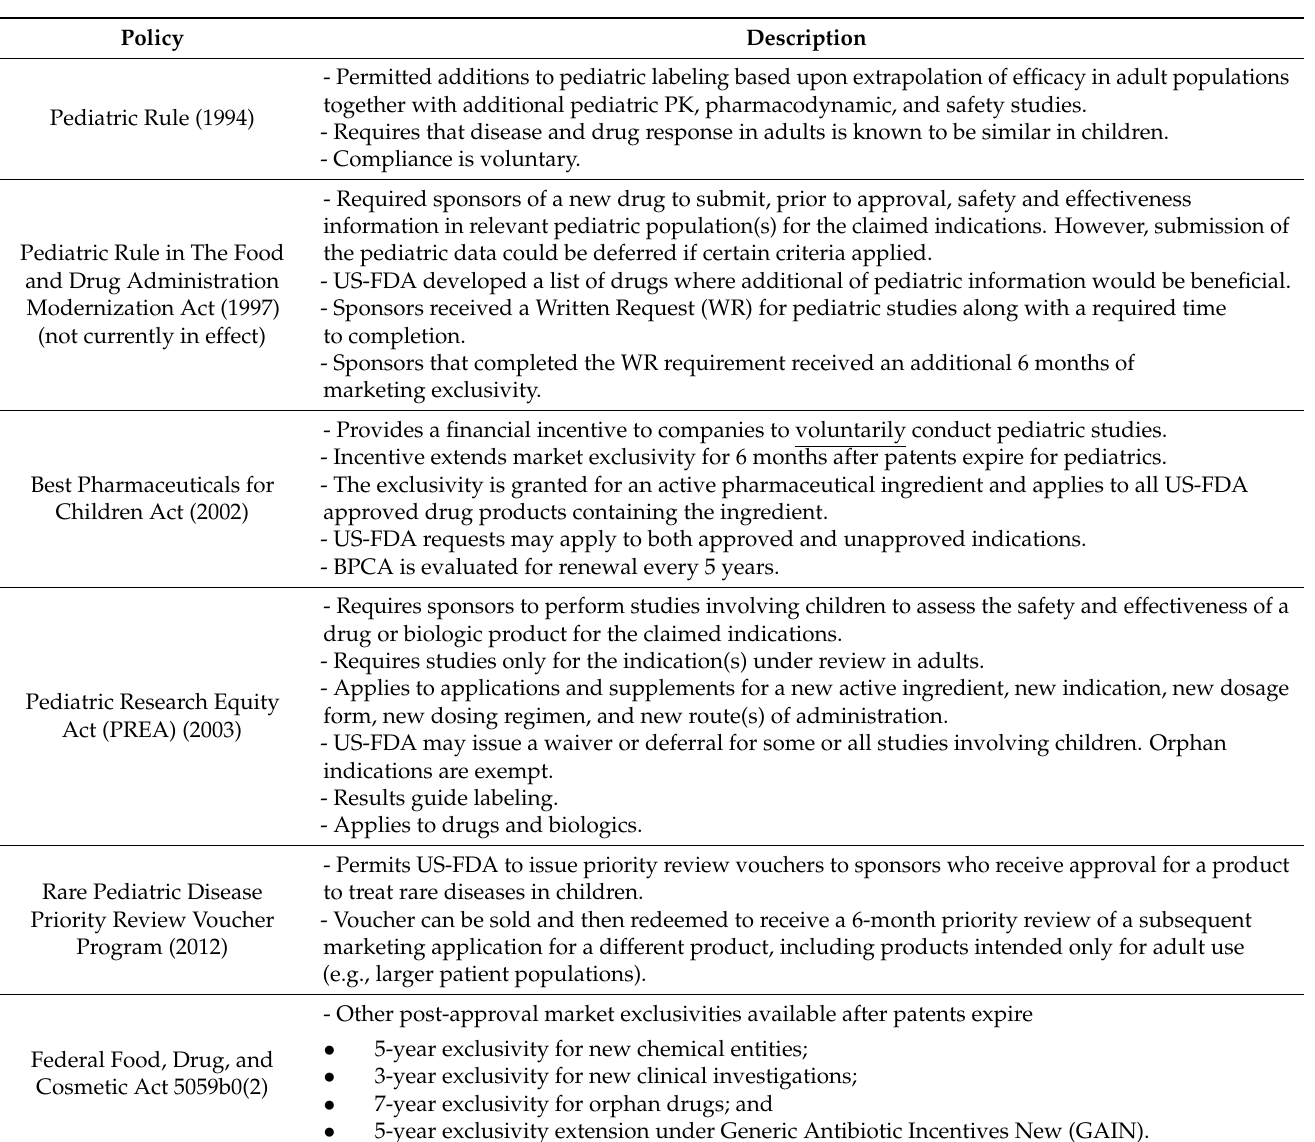
Table 2. Policies promoting evidence-based pediatric drug research and approvals for patented medications